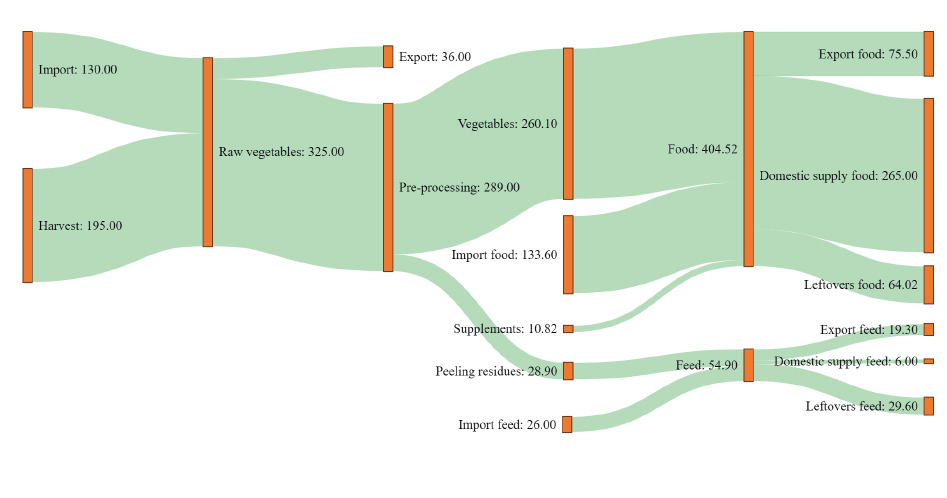
Fig. 6. Sankey diagram for bioresource flows of base scenario in 2015 for vegetables, thousand tonnes. Fig. 7 shows the flow of goods results for the 2030 baseline scenario. The main changes compared to 2015 are in the production of vegetables for food and feed, as the demand for food has decreased by 22 %, which can be explained by the declining population, but due to the increase in the world's population, vegetable exports are increasing. Demand for fodder has also declined, as the total number of livestock is expected to decline slightly.